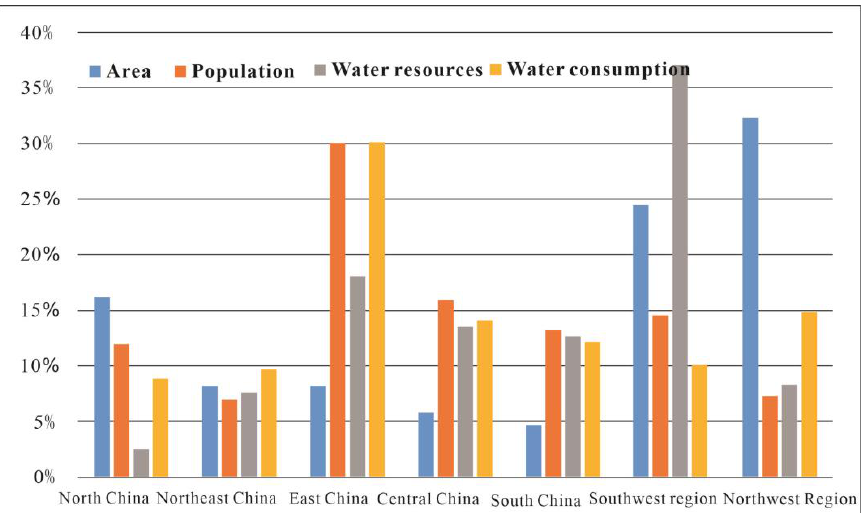
Figure 5. Proportion of geographical area, population, water resources, and water consumption in the country in 2020. North China: Beijing, Tianjin, Hebei, Shanxi, and Inner Mongolia; Northeast: Liaoning, Jilin, and Heilongjiang; East China: Shandong, Jiangsu, Anhui, Shanghai, Zhejiang, Jiangxi, and Fujian; Central China: Henan, Hubei, and Hunan; South China: Guangdong, Guangxi, and Hainan; Southwest: Chongqing, Sichuan, Yunnan, Guizhou, and Tibet; Northwest: Shaanxi, Gansu, Ningxia, Qinghai, and Xinjiang.